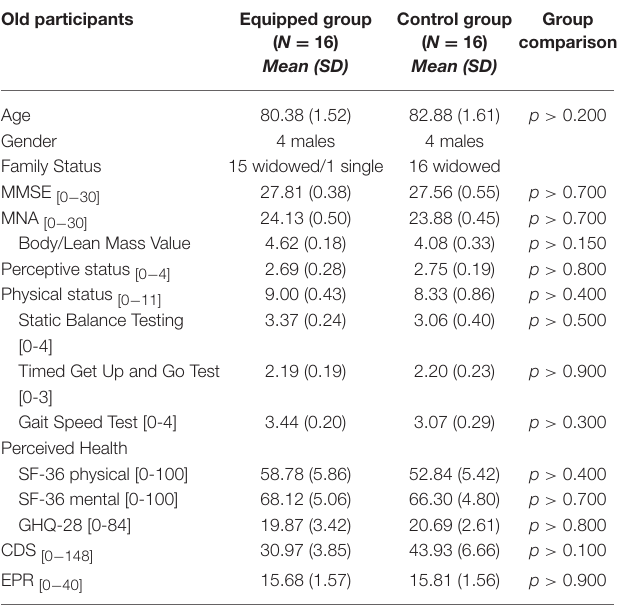
TABLE 1 | Participants’ characteristics for control and equipped